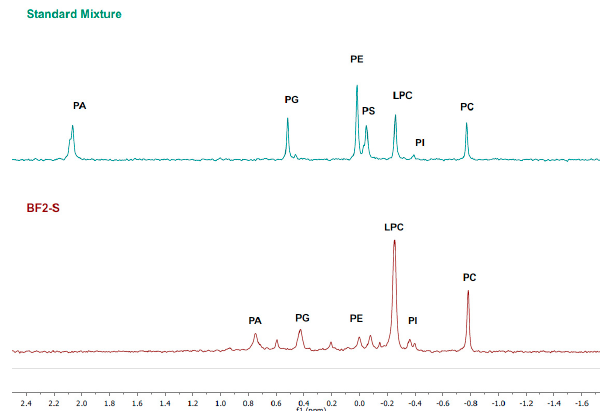
Figure 3. Comparison of 31 P NMR spectra of a standard mixture of PLs (green spectrum) with the BF2-S fraction (red